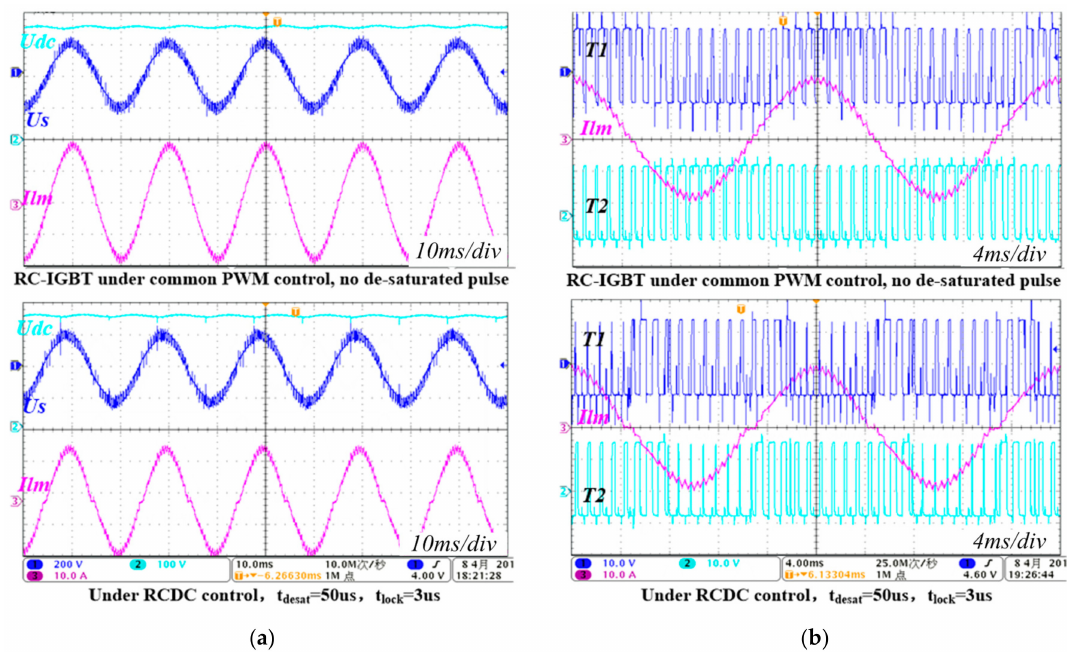
Figure 18. Waveforms of the input & output voltage and current under desaturation control, as well as saturated work, for RC-IGBT: ( a ) Waveforms of the input and output voltage, as well as the inductance current; ( b ) Waveforms of the current and T 1/ T 2 gate